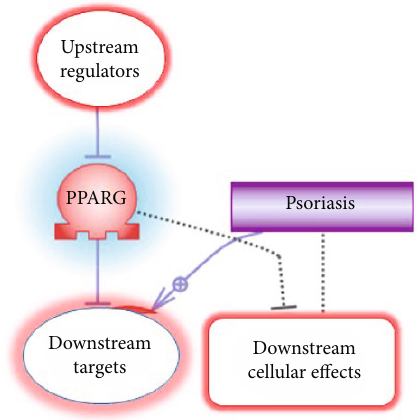
Figure 1: The logic of discovering the members of PPAR γ - downregulated subnetwork associated with